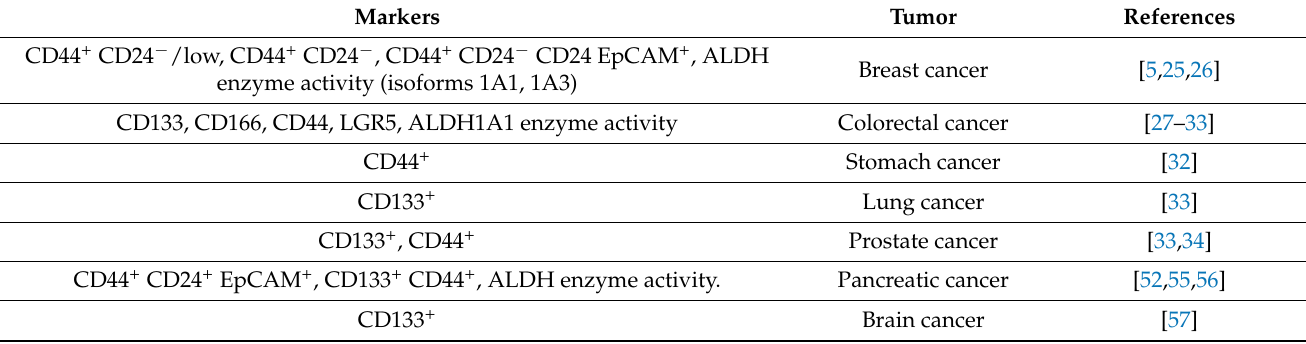
Table 1. Major cancer stem cell markers in the most common malignant